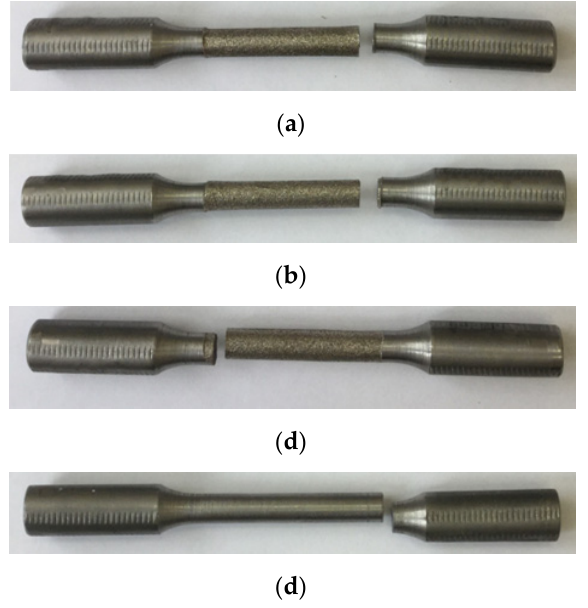
Figure 23. Photographs of low-cycle fatigue fractured specimens made by: ( a ) EDM (copper ET); ( b ) EDM (composite ET); ( c ) EDM (graphite ET); ( d ) turning.